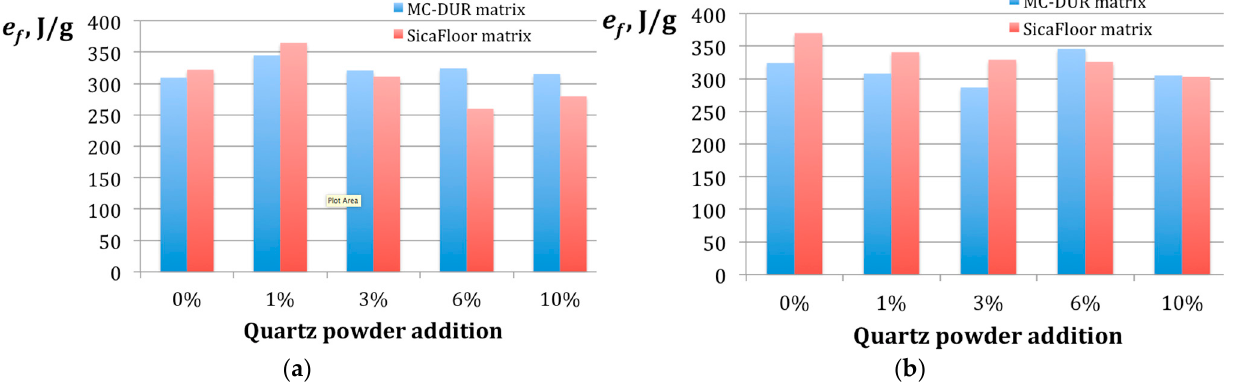
Figure 7. The average values of the specific wear rate e f obtained for the specimens of the different particulate filler proportions in the polymer matrices MC-DUR 1200VK and Sikafloor 156, pro- duced using different binders: ( a ) with the emulsion binder; ( b ) with the powder